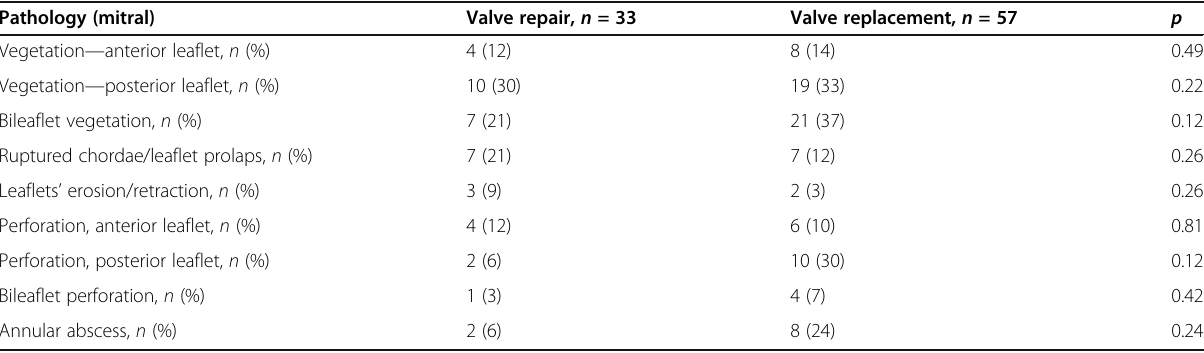
Table 1 Underlying valve disease in patients treated with valve repair and replacement Pathology (mitral) Valve repair, n =